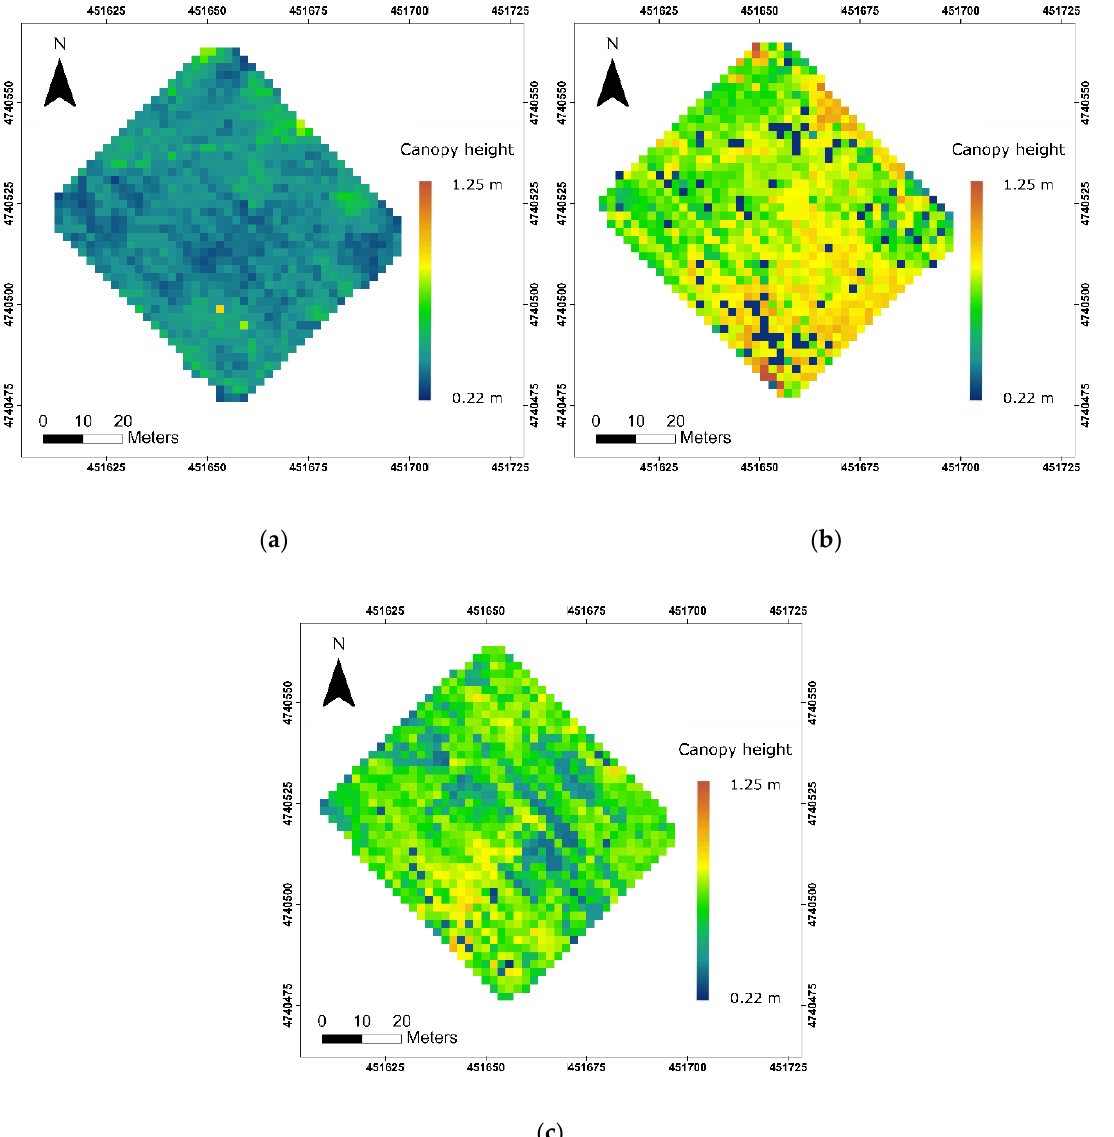
Figure 8. Raw maps of the winter wheat canopy height displayed as a cubic convolution interpretation. a) May 16; b) May 31; c) June 9.